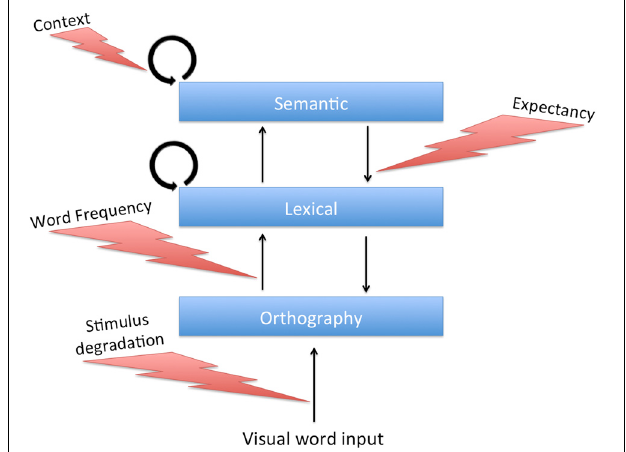
FIGURE 6 | Model architecture and information processing pathways with the addition of a simple “orthographic” layer. Task-dependent modulators of specific pathways are